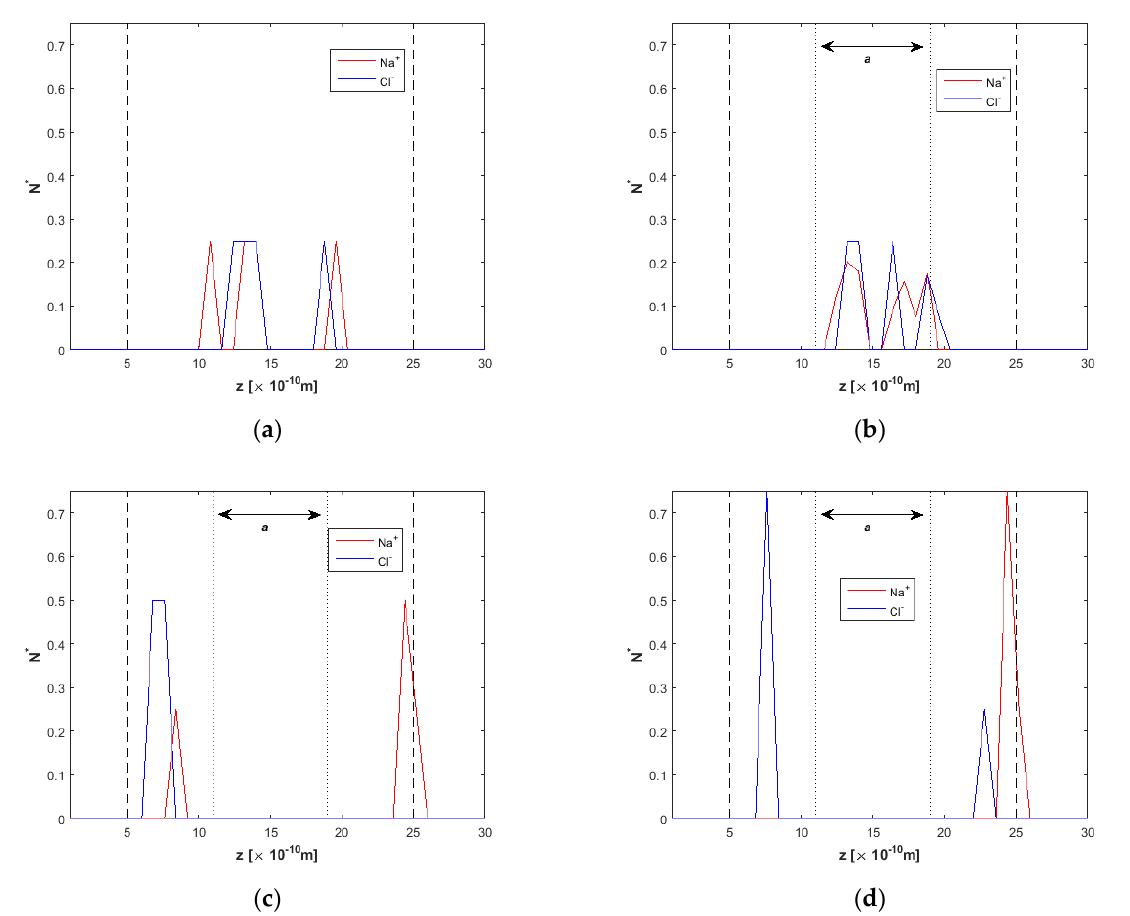
+ and Cl − ions have not been completely separated from each other. There are both